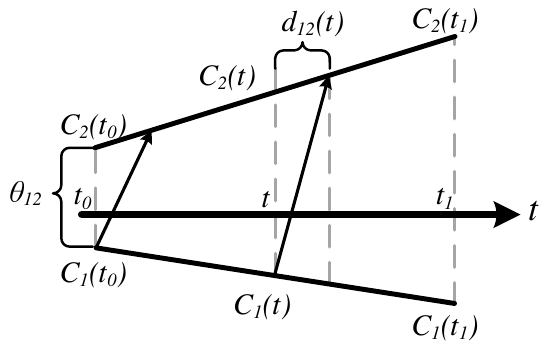
Figure 5. The relation between the reports of two clocks C 1 ( t ) and C 2 ( t )